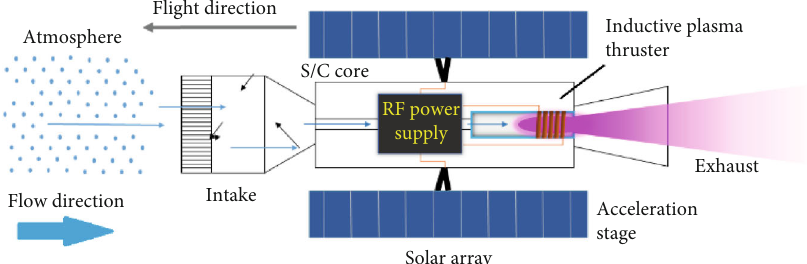
Figure 25: Inductive plasma thruster (IPT) system in the University of Stuttgart [60].